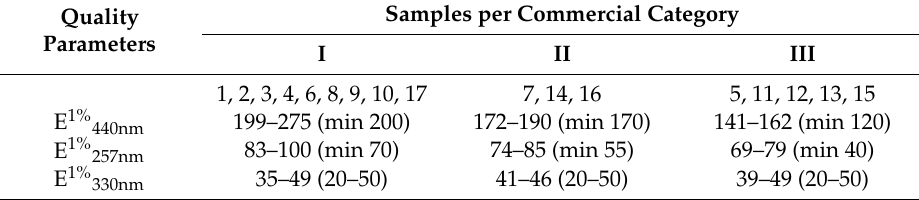
Table 1. Classification of the 17 commercial samples according to the ISO 3632 quality categories [22] soon after